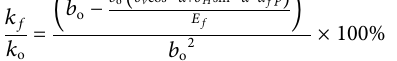
In the above, the parameters include fracture permeability after deformation k f , mD; Initial fracture permeability k o , mD; The normal displacement of the fracture u n , mm; Initial fracture